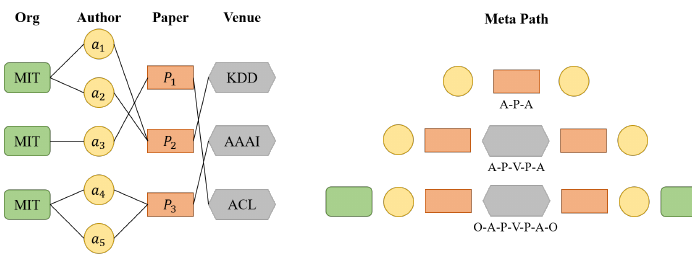
Figure 4. Local structure of heterogeneous graph